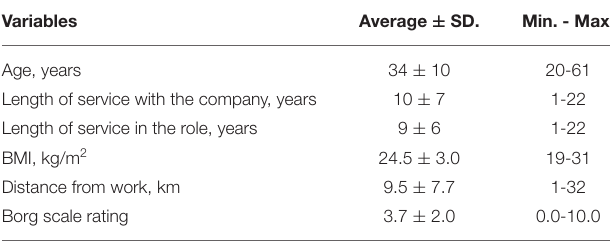
TABLE 1 | Characteristics of enrolled workers (no.